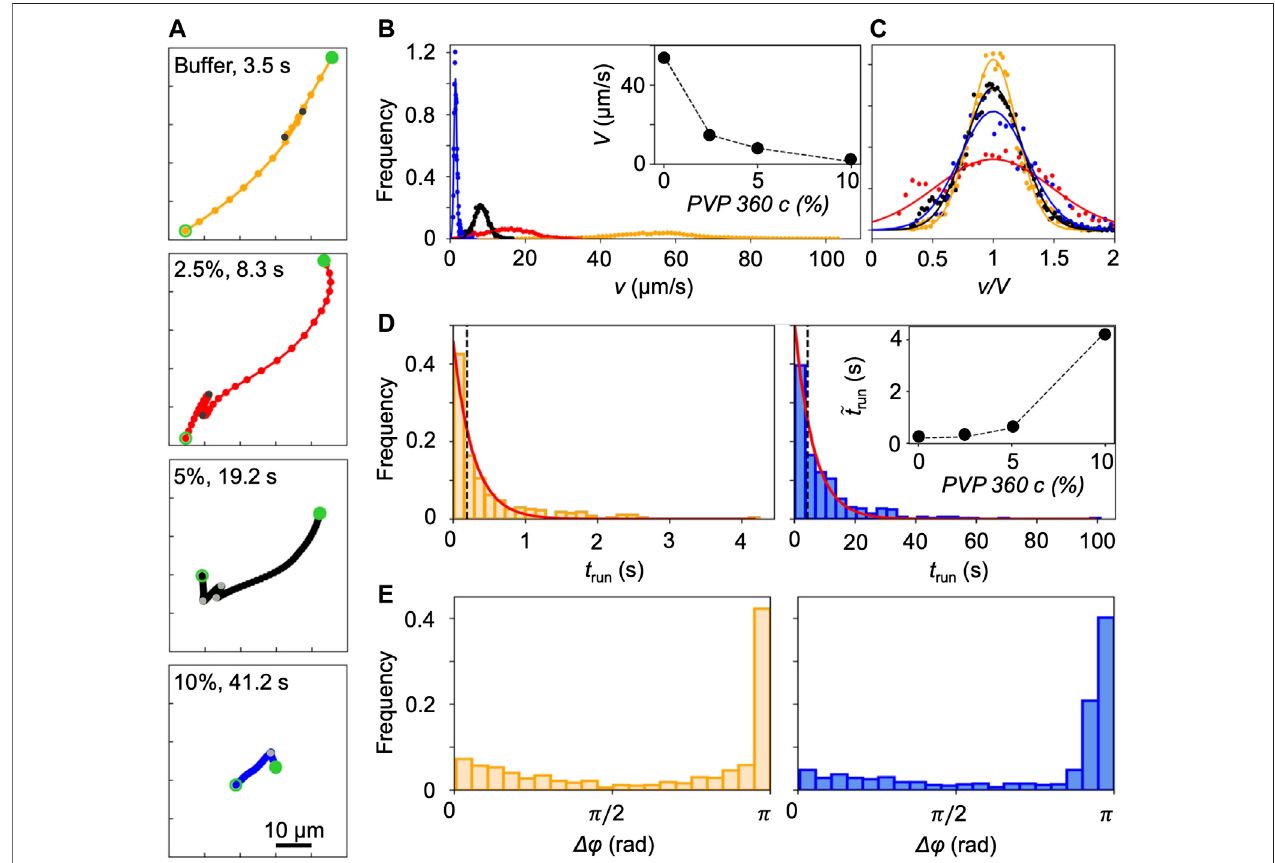
FIGURE2|(A) Typicaltrajectoriesof P.aeruginosa cellsswimminginbuffer(yellow)andinPVP360solutionsat2.5w/v%(red),5w/v%(black),and10w/v%(blue) without fl ow.Thetrajectoriesbeginatopen greencirclesandendat fi lledgreencircles.Grey fi lledpointsmarktheend ofarun.Thetimeintervalbetweendotsisequalto 0.2 s. (B) Distribution of swimming velocities, v , measured by tracking individual cells in a population of P. aeruginosa swimming in buffer (yellow), PVP 360 solutions at 2.5 w/v% (red), 5 w/v% (black), and 10 w/v% (blue) in no- fl ow conditions. The continuous curves are Gaussian fi ts with the mean velocities V reported in the inset. (C) Distribution of swimming velocities reported in panel (B) as a function of the normalized velocity v/V . (D) Distribution of the transit times t run measured by tracking individual cells in a population of P. aeruginosa swimming in buffer (left panel) and in PVP 360 10 w/v% (right panel). The red curves are the exponential fi ts of